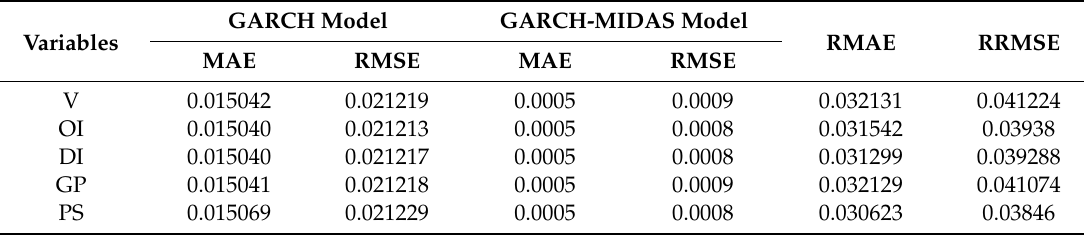
Table 16. RMAE and RRMSE values of GARCH model and GARCH-MIDAS model.